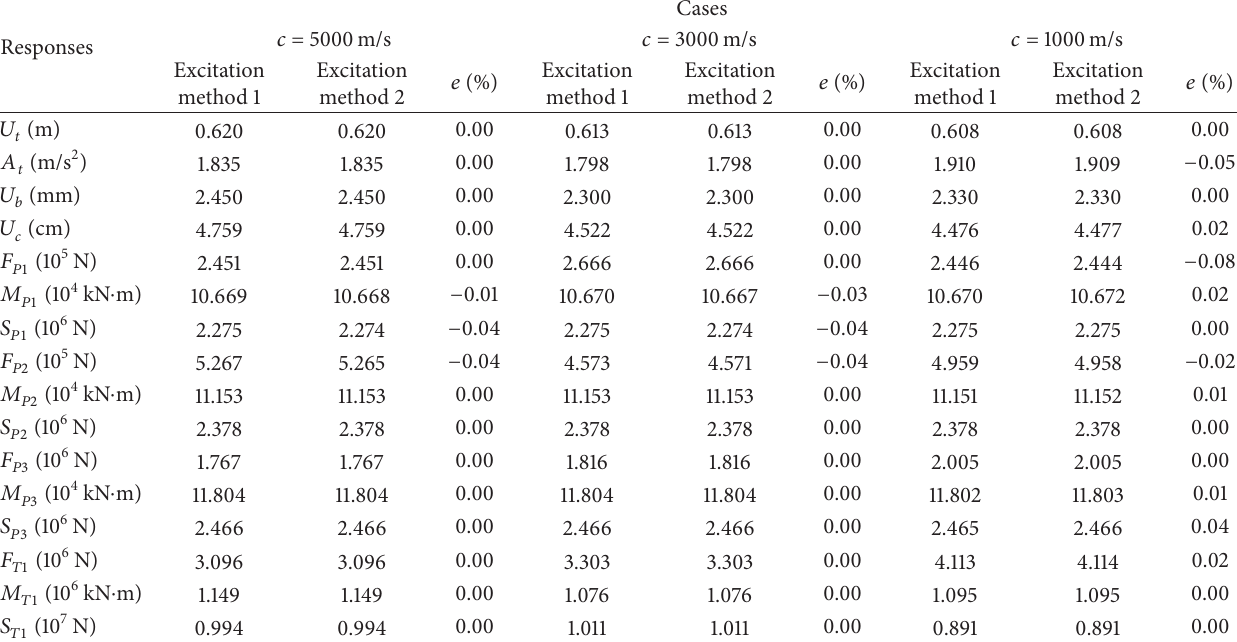
Table 6: Comparisons of the structural peak seismic responses under different excitation methods under the excitation of 𝑎 1 .